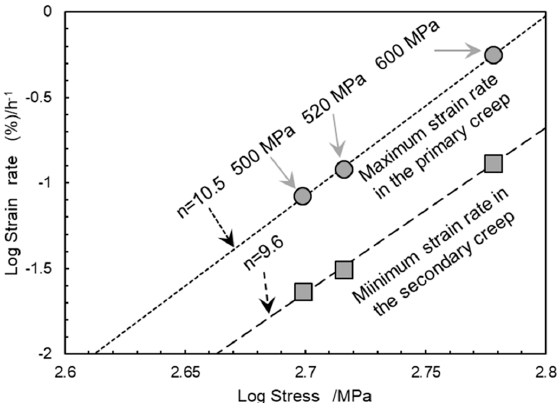
Figure 5. Change in the strain rate as a function of strain in the ( a ) primary creep region, ( b ) secondary creep region.